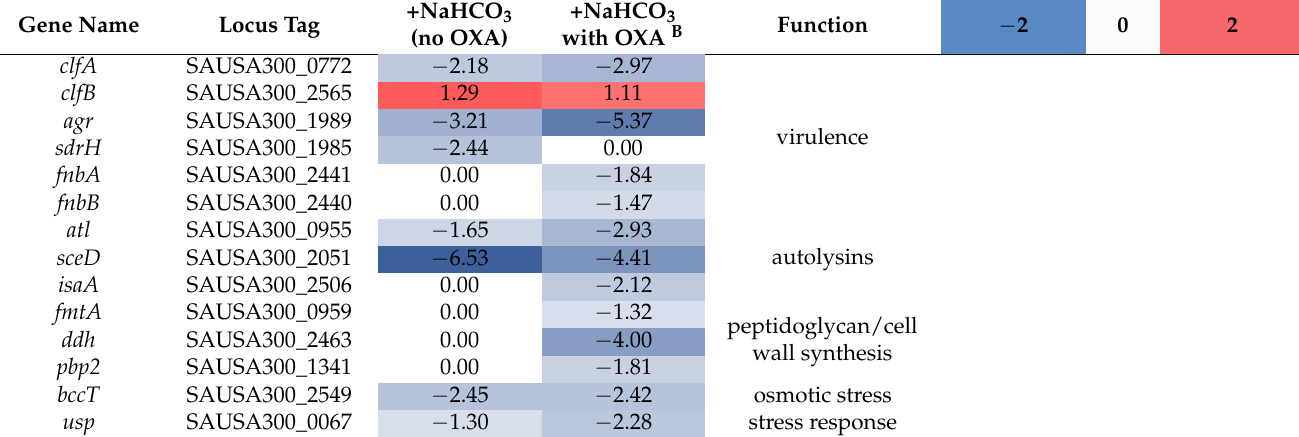
Table 2. Genes of interest selectively altered in NaHCO 3 -responsive strain MRSA 11/11 (log 2 fold change A ).